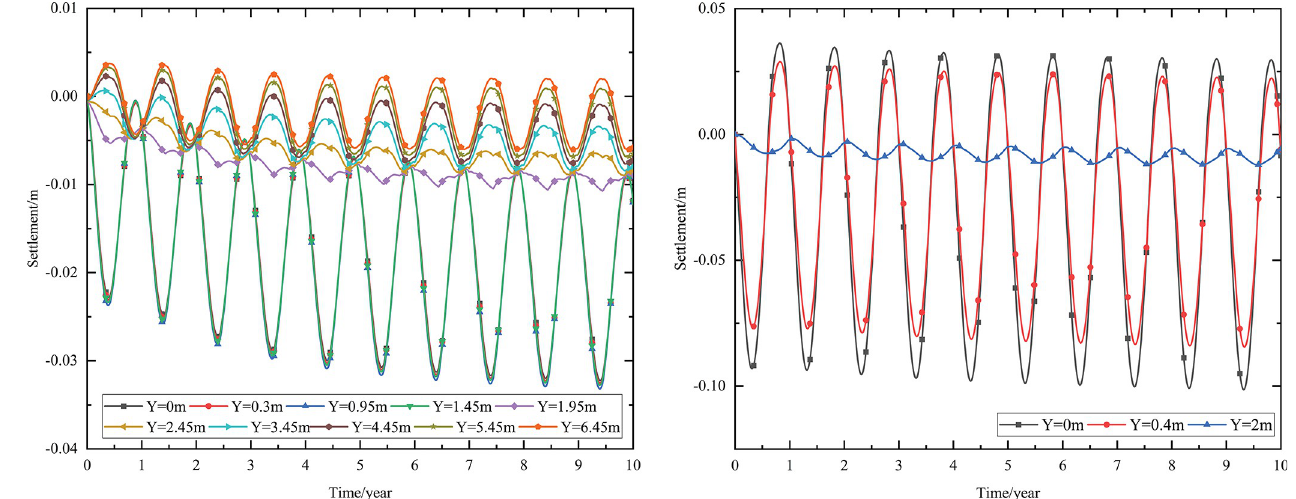
Fig 16. Settlement-time curves under the static load of the aircraft at the (a) pavement center and (b) natural surface center.